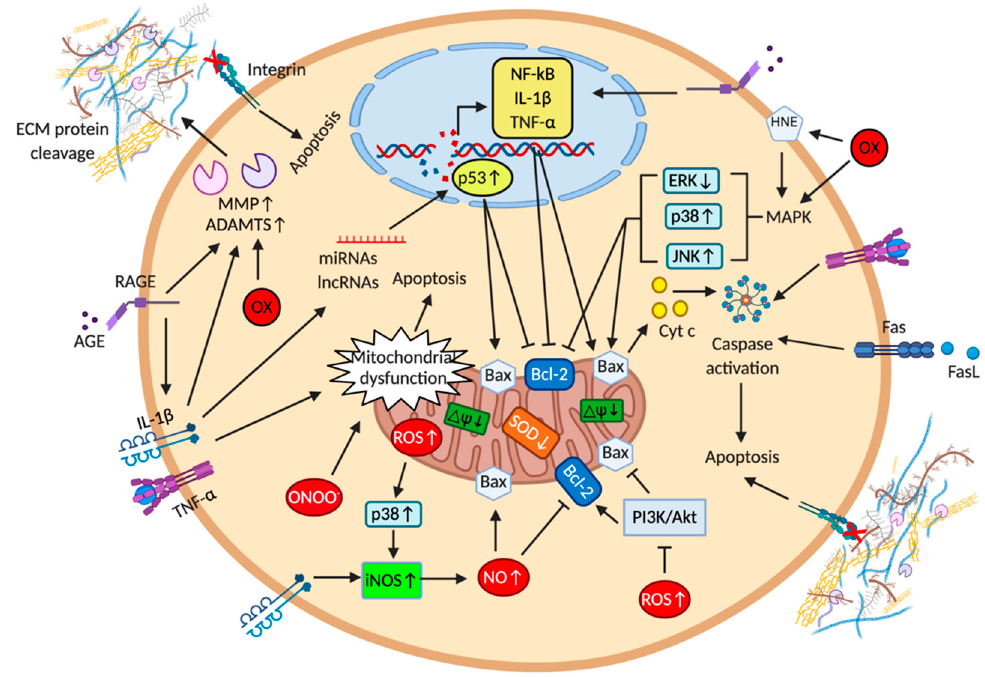
Figure 3. Schematic representation of extrinsic and intrinsic factors involved in chondrocyte apoptosis. Abbreviations: ADAMTS = disintegrin and metalloproteinase with thrombospondin motifs; AGE = advanced glycation end products; Bax = Bcl-2-associated X; Bcl-2 = B-cell lymphoma protein 2; Cyt c = cytochrome c; ∆Ψ = mitochondrial membrane potential, ECM = extracellular matrix; ERK = extracellular-signal-regulated kinase; FasL = Fas ligand; HNE = 4-hydroxynonenal; IL-1 β = interleukin 1 beta; iNOS = inducible nitric oxide synthases; JNK = c-Jun N-terminal kinases; LncRNAs = long non-coding RNA; MAPK = mitogen-activated protein kinase; miRNAs = microribonucleic acids; MMP = matrix metalloproteinases; NF- κ B = nuclear factor kappa-light-chain-enhancer of activated B cells; NO = nitric oxide; ONOO − = radical peroxynitrite, OX = oxidative stress; PI3K/Akt = phosphatidylinositol 3-kinase/protein kinase-B; RAGE = receptor for advanced glycation end products, ROS = reactive oxygen species; SOD = superoxide dismutase; TNF- α = tumor necrosis factor alpha.